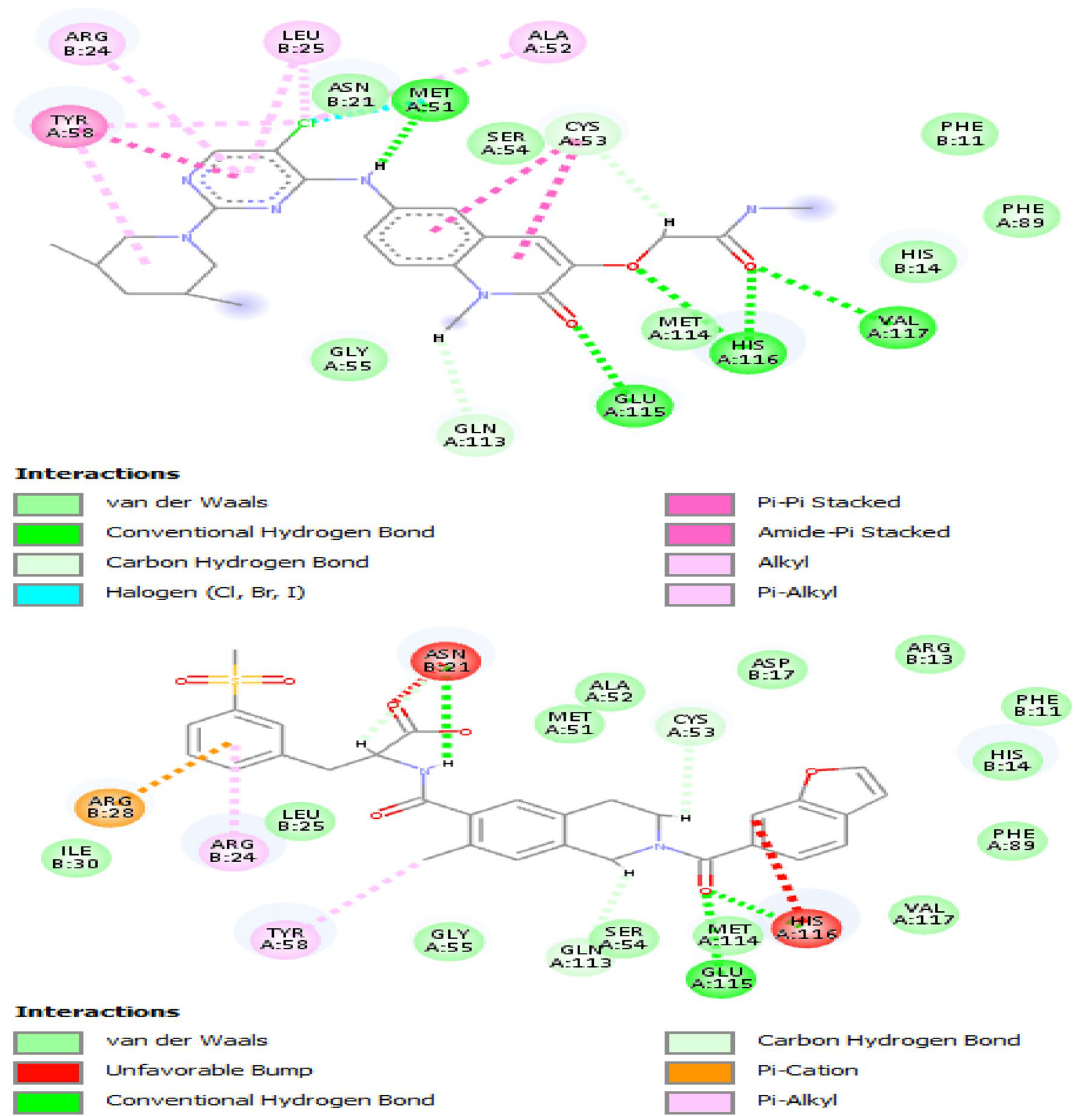
Figure 4. The 2D plot for interaction between BI-3802 (upper plot) and Lifitegrast (lower plot) and the BCL6. The involved amino acids are in spheres (three-letter amino acid name, chain ID, and the amino acid number in the protein sequence) and the formed bonds are depicted as a dashed